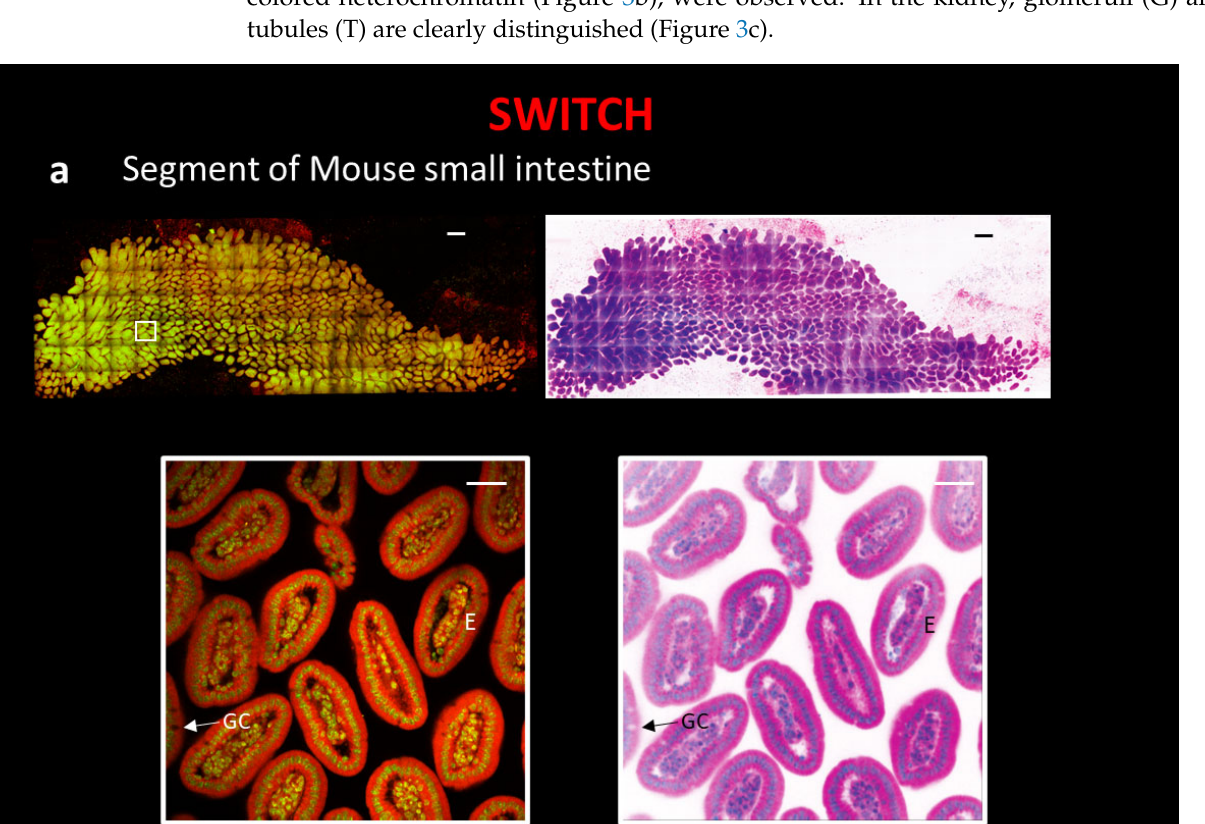
Figure 3. Reconstruction of tissue sections using the combination of SWITCH clearing protocol and TPFM. All sections in the figure are stained with Eosin and DAPI. Next, and under all images of the entire section, a zoom ‐ in on a particular region of interest (ROI) is represented with traditional H&E fluorescent staining and pseudo ‐ coloration. The following sections are: ( a ) A segment of mouse